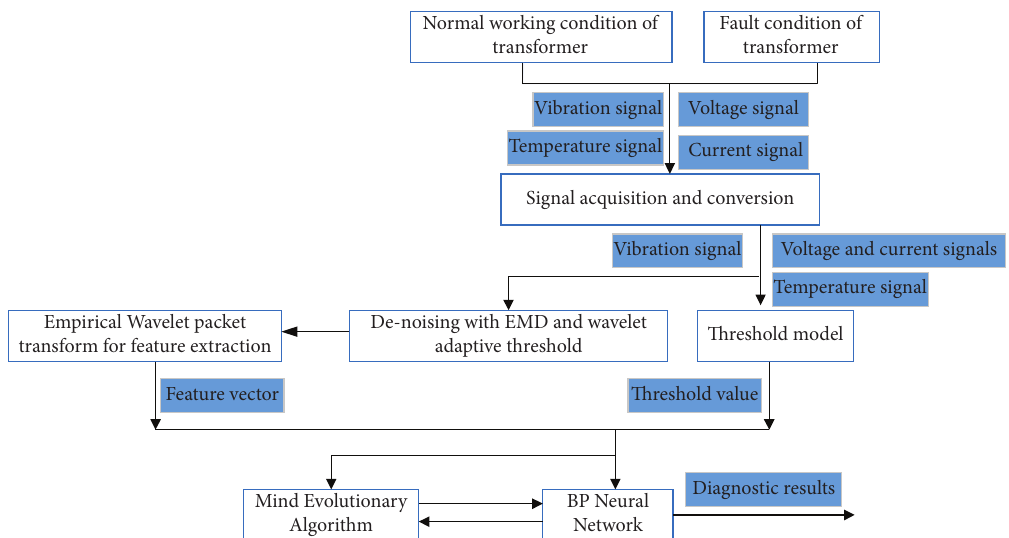
Figure 7: Flowchart of the proposed diagnostic